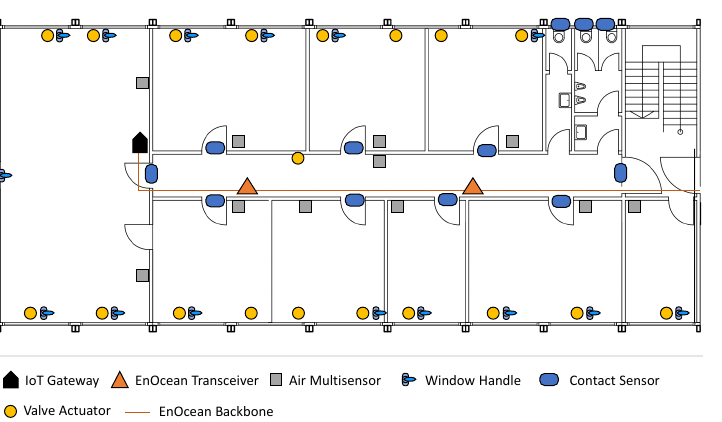
Figure 3. Equipment concept for a floor and wing of an examplary building layout using